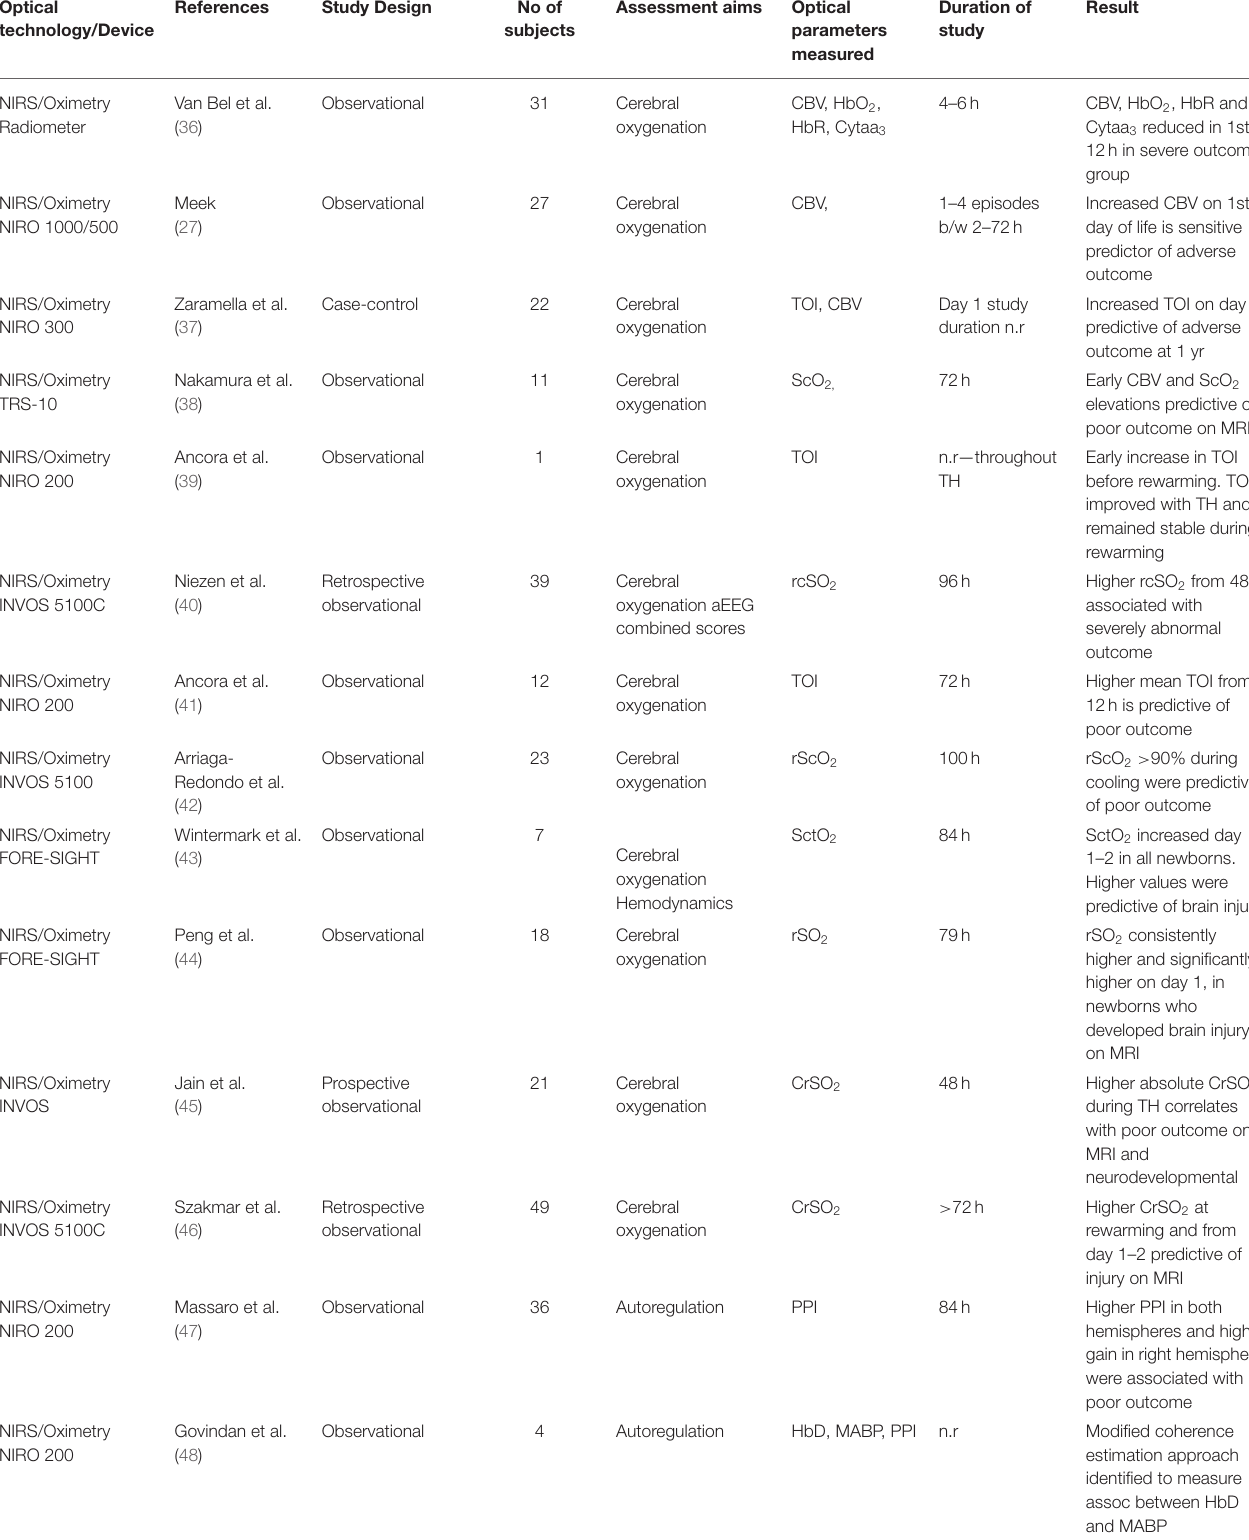
TABLE 1 | Clinical and relevant recent pre-clinical optical studies in Neonatal Encephalopathy: